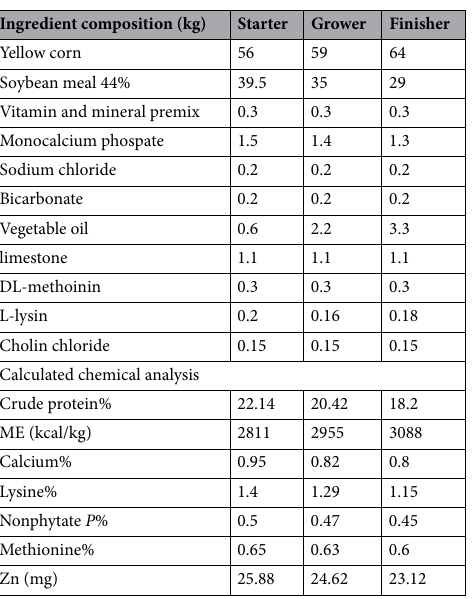
Table 1. Ingredient composition and calculated chemical analysis of the basal diets. Vitamin-mineral premix provided per kg of diet: vitamin A, 14,000 IU; vitamin D3, 3,000 IU; vitamin E, 34.5 IU; vitamin K3, 4 mg; biotin, 0.15 mg ;vitamin B1, 1.3 mg; vitamin B2, 6 mg; pantothenic acid, 20 mg; vitamin B6,3 mg; niacin, 60 mg; vitamin B12, 6 mg; choline, 150 mg; folic acid,0.5 mg. Mn, 60 mg; Fe, 50 mg; Cu, 10 mg; I, .1.5 mg; Se, 0.2 mg; Zn, 0